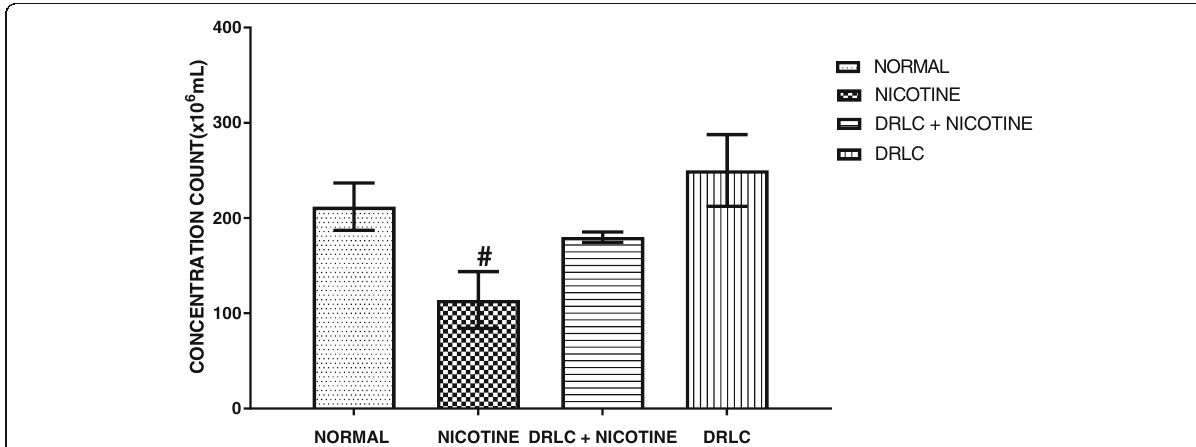
Fig. 7 Chart showing the sperm concentration of the experimental animals. Values are mean ± SEM. N = 5. # Statistically different from Normal and D-ribose L -cysteine group at p <